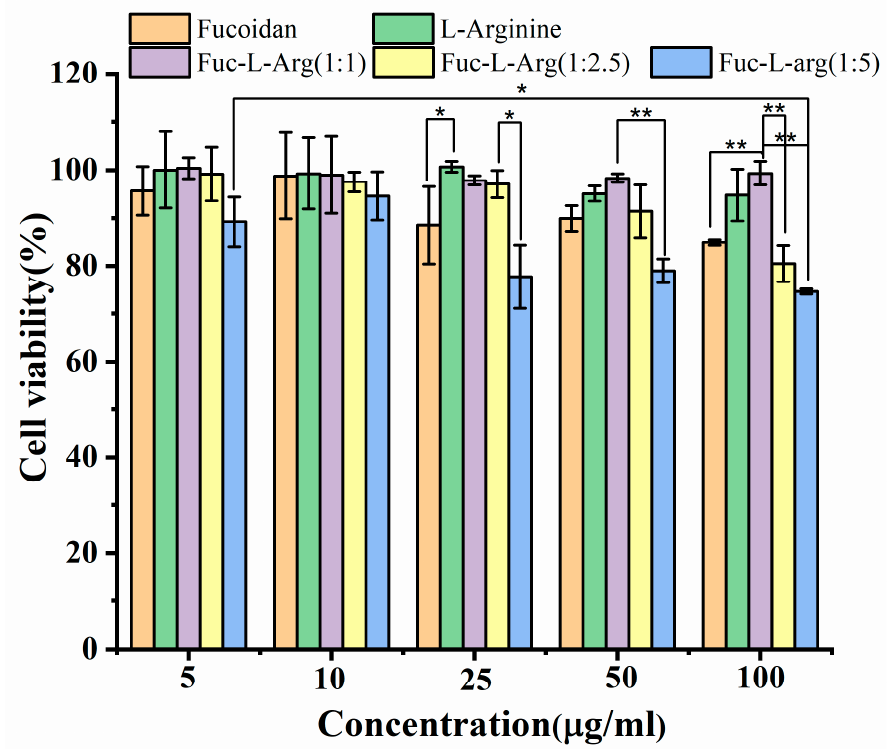
Figure 7. Cell viabilities of pristine fucoidan, pristine L-arginine, and the Fuc-L-Arg complexes (1:1, 1:2.5, and 1:5) in HeLa cells. Where * represents p < 0.05, ** p < 0.01.